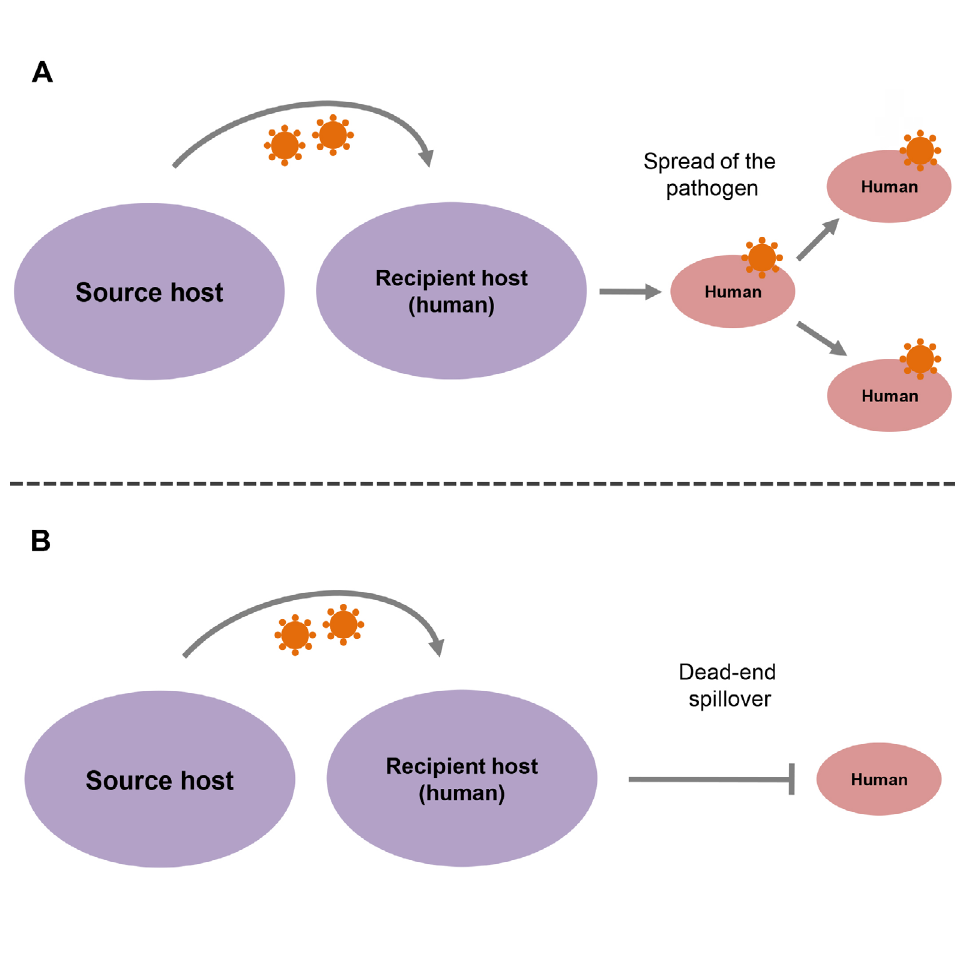
Figure 4 - Outcomes after a spillover event. A spillover event can have two basic outcomes. A: the pathogen that crossed the barriers between species can spread among the population (through human-to-human transmission or a highly competent vector). This outcome will occur if the social, biological, and environmental conditions are favorable for the adaptation of the pathogen in the human host and its transmission among the new population. B: the pathogen is transmitted to a human, but without spreading among the human population due to the absence of social, biological, or environmental conditions favorable to the adaptation of the pathogen to the human population or its dissemination. This condition is called dead-end